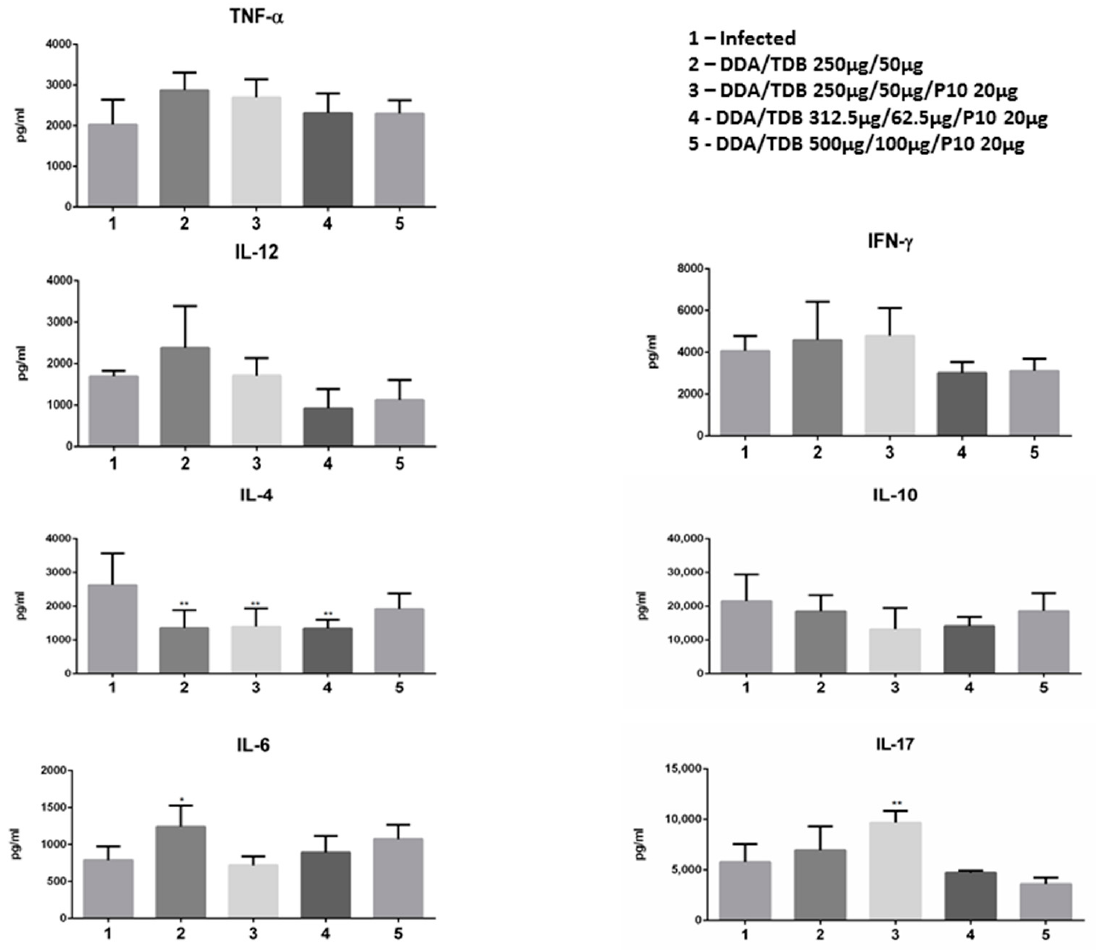
Figure 3. Evaluation of immune responses induced by P10 peptide adsorbed on DDA/TDB liposomes. Th 1 , Th 2 , and Th 17 -associated cytokines were measured in pulmonary homogenates 75 days after infection by capture enzyme-linked immunosorbent assay (ELISA). Infected mice with P. brasiliensis received three doses of either PBS as a control (1), DDA/TDB alone (2), or different concentrations of DDA/TDB with P10 (3–5). The data are shown are the mean and SD of results from three independent experiments using 6 mice per group. The asterisk represents a statistically significant difference * p < 0.05 and ** p < 0.01.